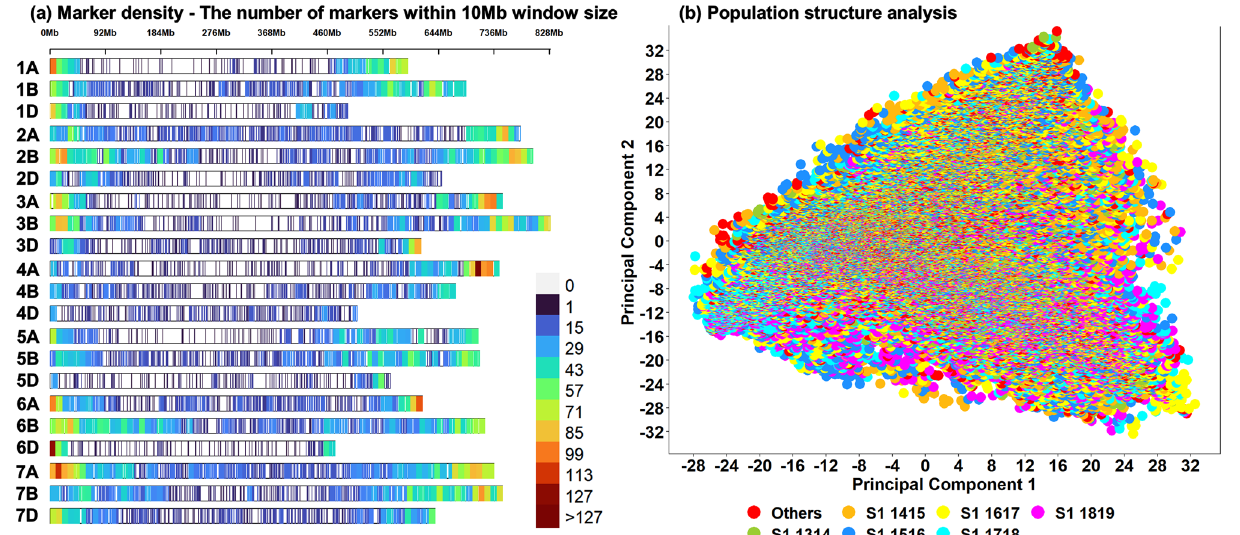
Figure 1. ( a ) Densities of 25,804 genotyping-by-sequencing markers in the reference bread wheat genome (RefSeq v1.0). The color key with marker densities indicates the number of markers within a window size of 10 Mb. ( b ) Population structure analysis of 55,568 lines. The plot of the first two principal components explaining 5.8% and 5.2% of the variation, respectively indicated weak population structure with high relatedness between the lines in the Stage 1 (S1) panels across crop cycles 2013–2014 (referred to as S1 1314) to 2018–2019 (referred to as S1